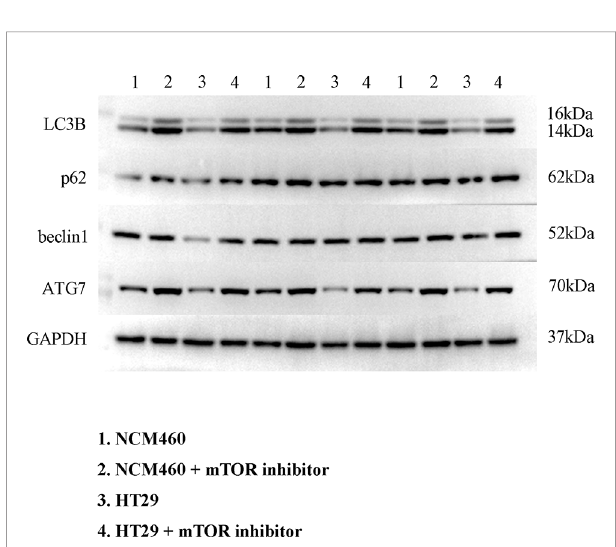
FIGURE 11 | Expression of autophagy-related proteins after autophagy